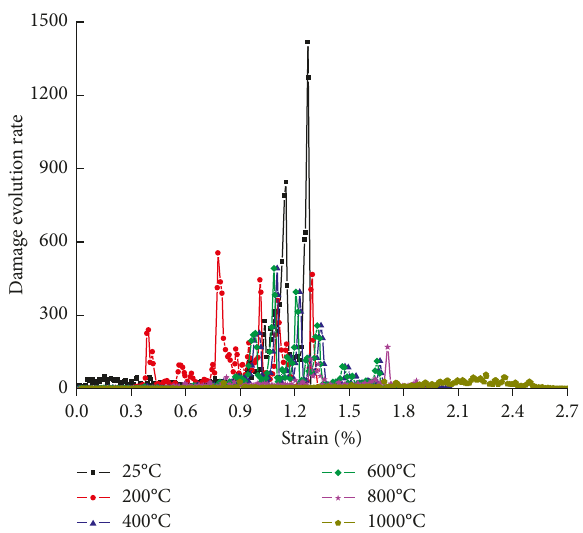
Figure 15: Damage evolution rate at various temperatures.